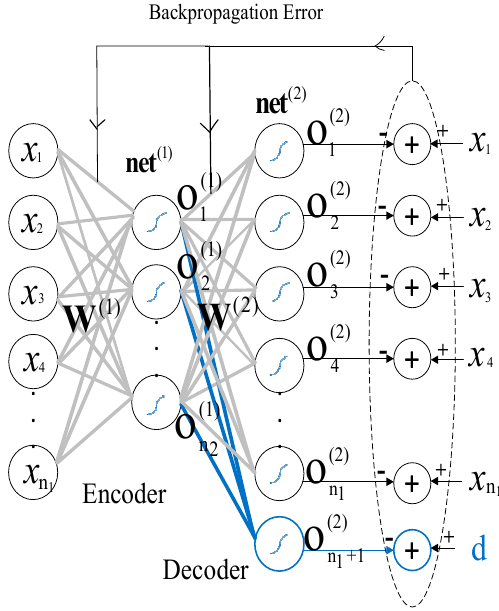
Figure 2. Schematic of the asymmetric auto-encoder [24].